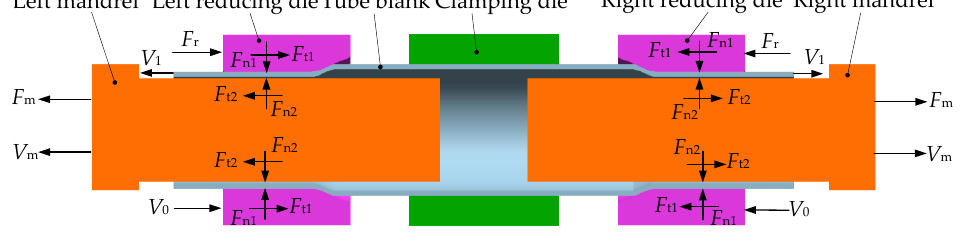
Figure 25. Process of PPDR.